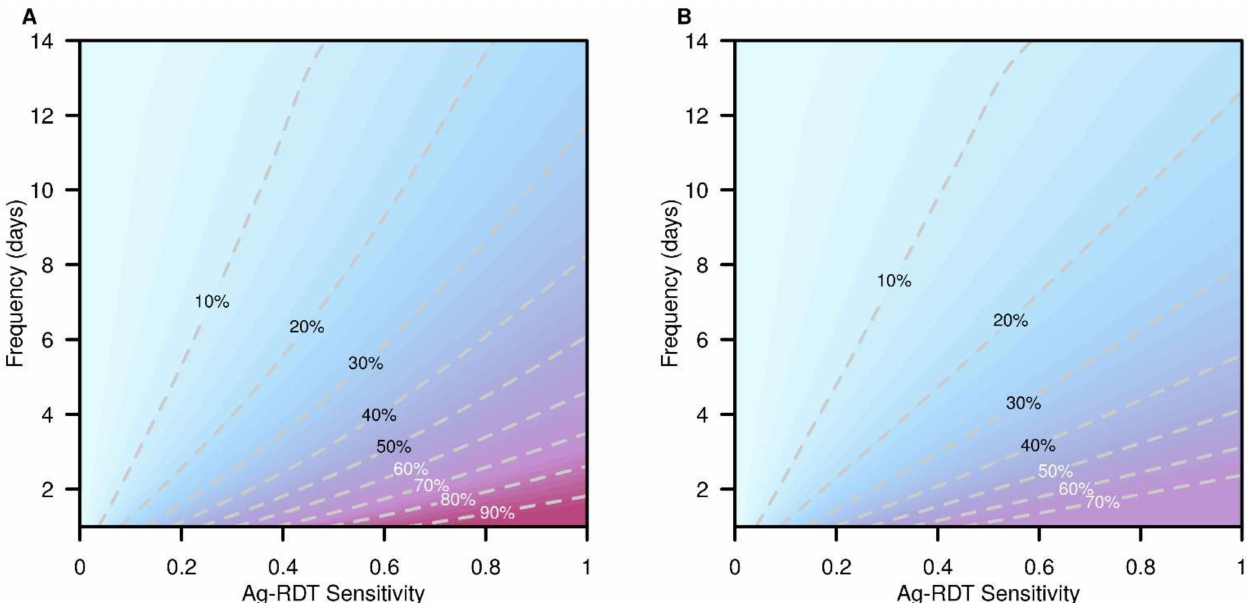
Figure 4. Percentage reduction in COVID-19 infections with various RRTs. Infection reduction values derived from the generalized additive model, with reductions at various test frequencies and maximal Ag-RDT sensitivities. ( A ) Infection reductions from the baseline with RRT at early implementation. ( B ) Infection reductions from the baseline with RRT at peak implementation.